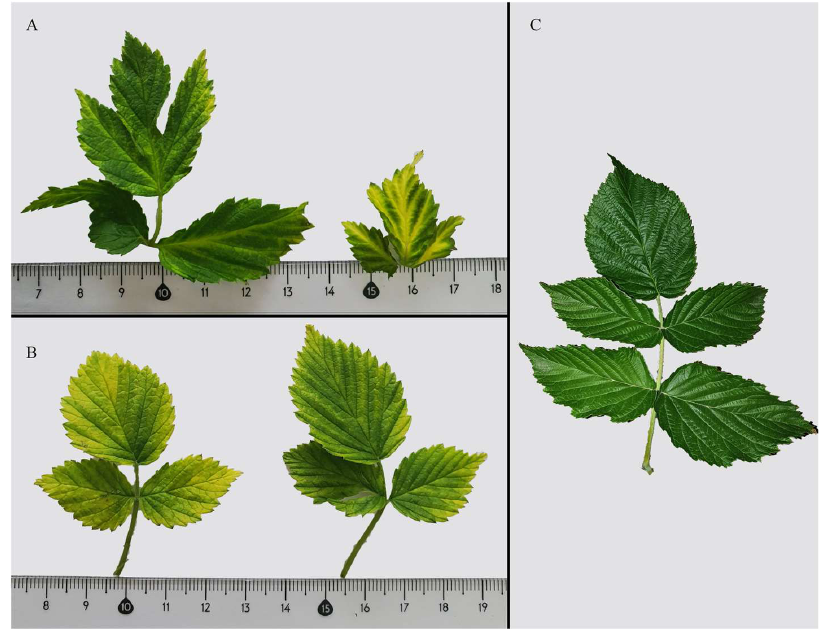
Figure 1. Plant images showing virus-like symptoms of RBDV infection in samples KZWild2 ( A ) and KZWild4 ( B ), as well as a healthy raspberry plant ( C ). The raspberry samples were tested for the presence of RBDV, as well as raspberry ringspot virus (RpRSV), raspberry leaf mottle virus (RLMV), and raspberry leaf blotch virus (RLBV) via PCR assays with specific primers targeting the conserved regions inside different protein genes (Table